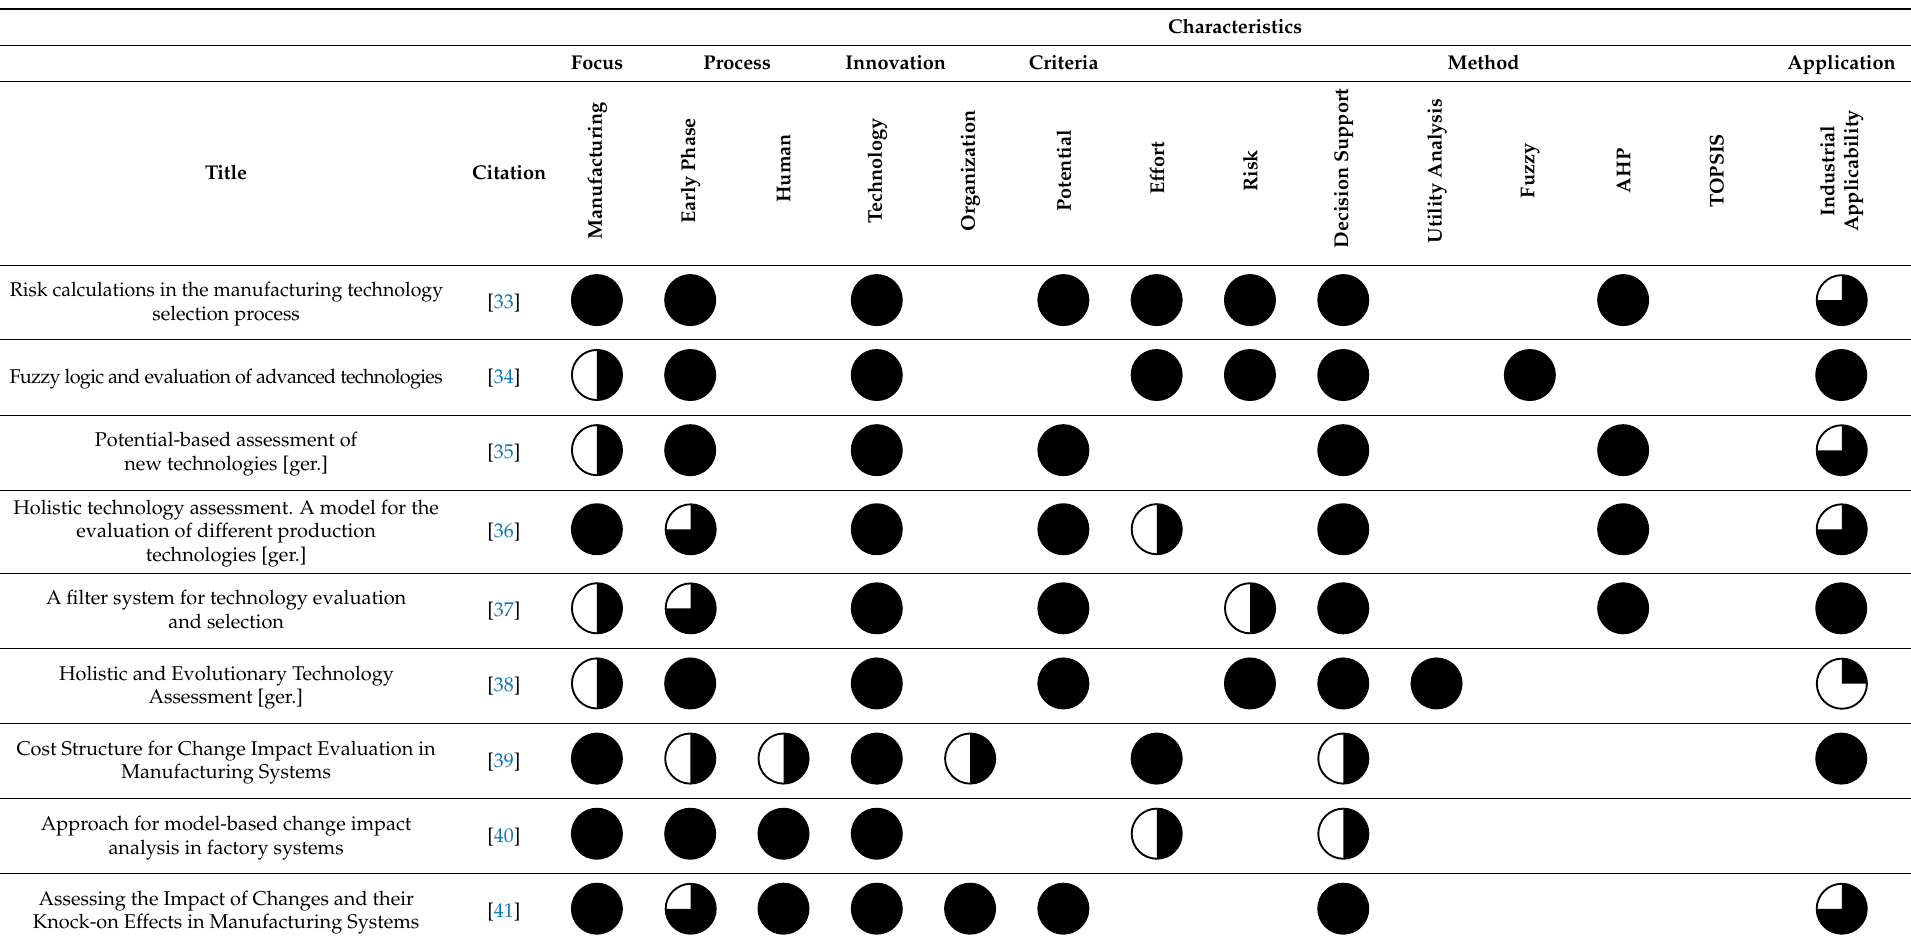
Table 2. Result analysis for the investigated methodical approaches.